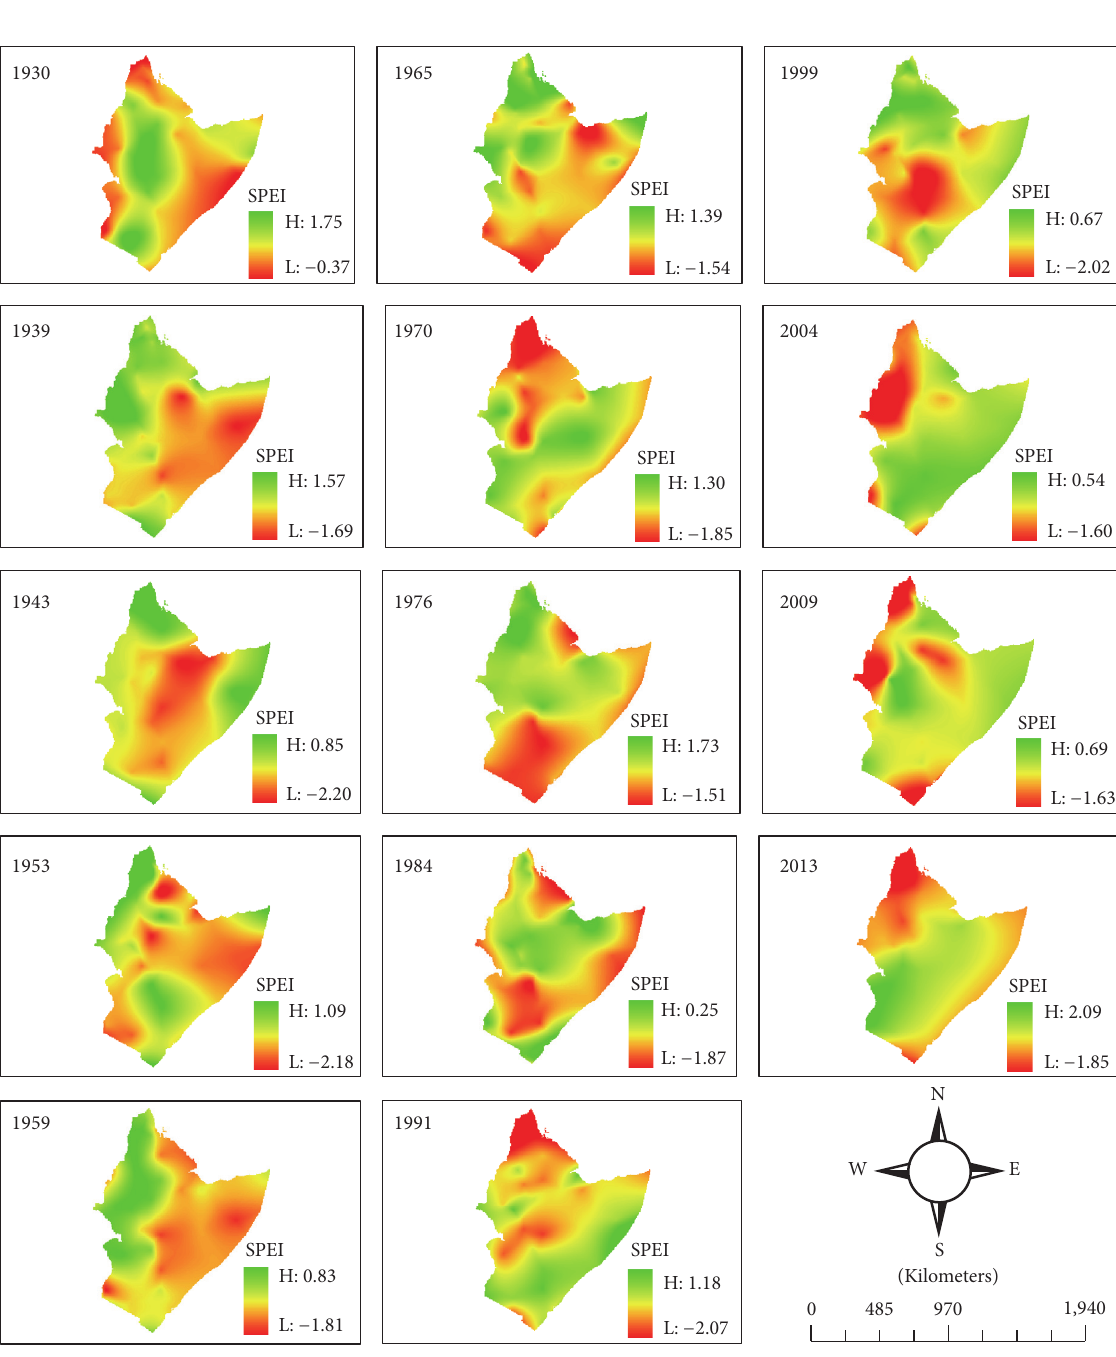
Figure 6: The drought condition of the HOA from SPEI probably during the selected Eli Nino years from 1930 to